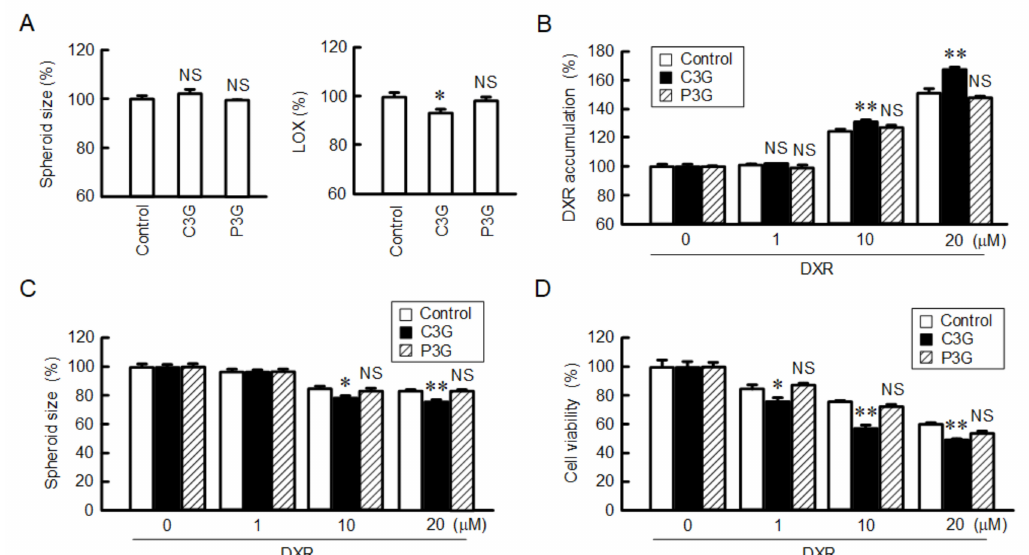
Figure 10. Increase in DXR-induced toxicity by C3G in spheroid cells. Cells cultured on PrimeSurface 96U multi-well plates were treated with 0 µ M (control) and 50 µ M anthocyanins for 24 h. ( A ) The spheroid size and fluorescence intensity of LOX-1 are represented as a percentage relative to control. ( B ) After treatment with anthocyanins, the cells were incubated with DXR at the indicated concentrations for 1 h. The accumulation of DXR is represented as a percentage relative to 0 µ M DXR. ( C , D ) The cells were incubated with DXR at the indicated concentrations for 24 h. The spheroid size and cell viability are represented as a percentage relative to 0 µ M DXR. n = 4–6. ** p < 0.01, * p < 0.05, and NS p > 0.05 compared with